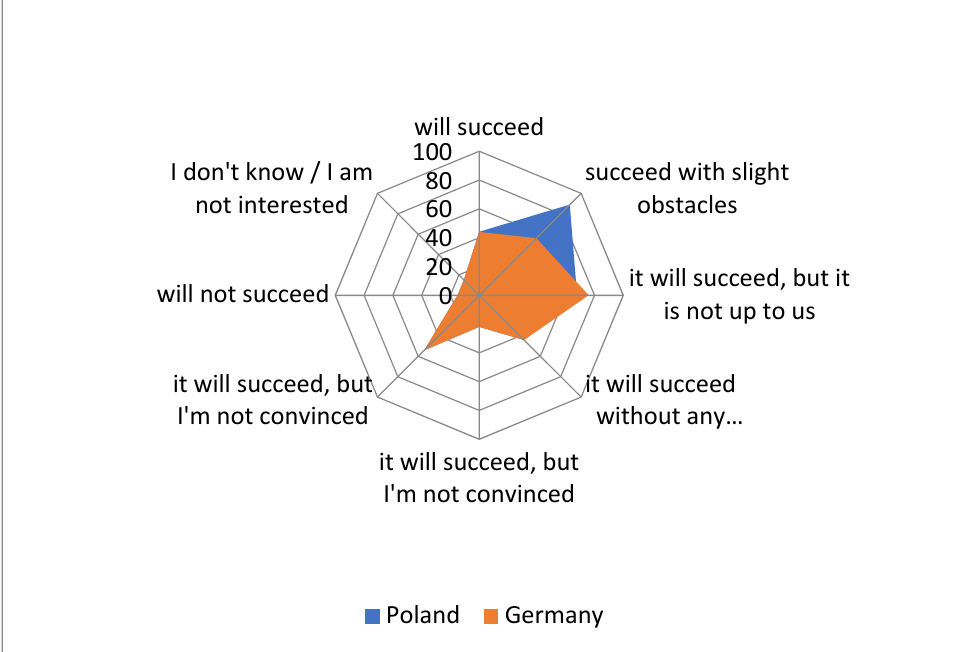
Figure 23. Opinion of people/entrepreneurs launching innovation sharing. The opinions of people/entrepreneurs with knowledge in the field of innovation contain similar values, but in turn, success with minor obstacles is around 15% greater in the case of Germany.